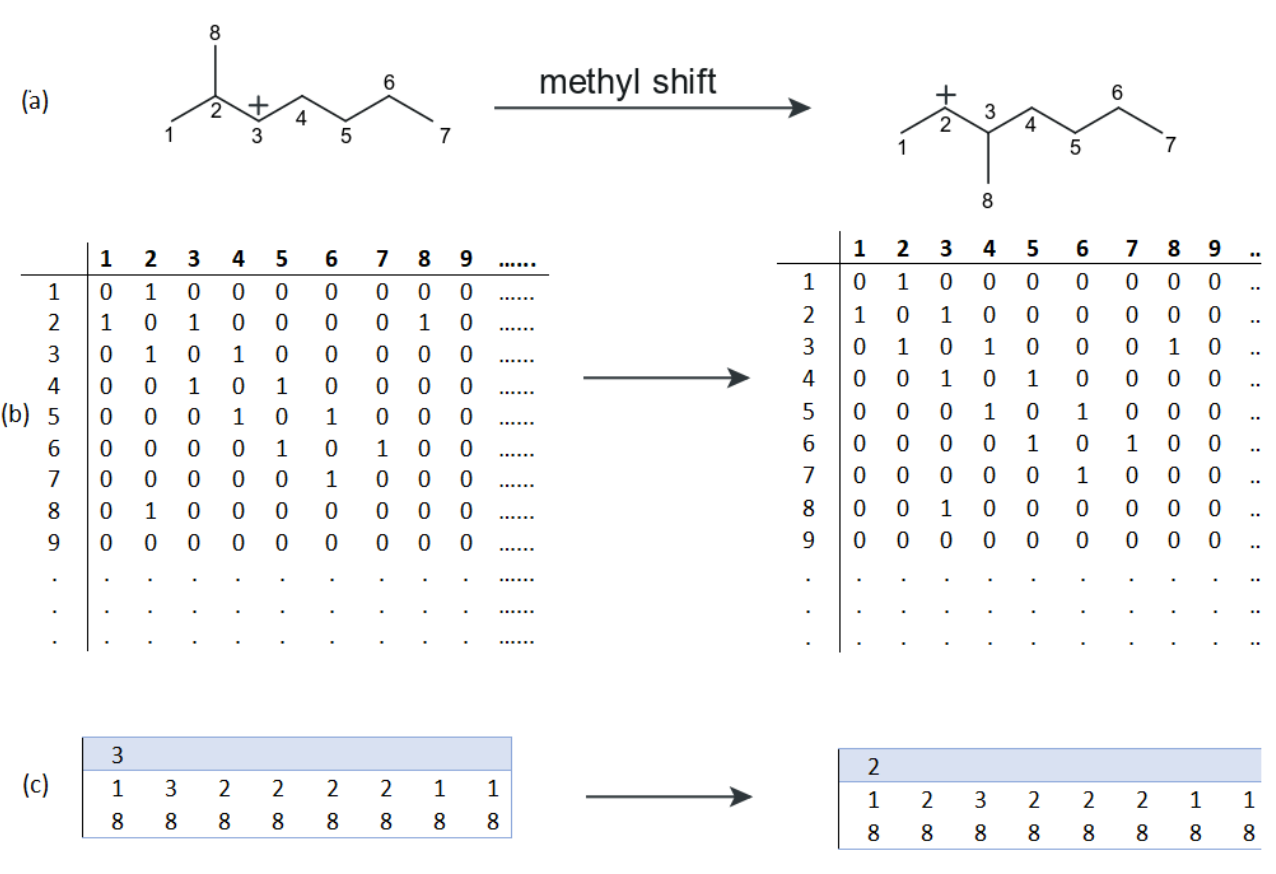
Figure 6. Representation of a methyl shift elementary step of a carbenium ion: ( a ) skeletal form, ( b ) Boolean matrix representation, ( c ) auxiliary vectors for the transformation (7 = unsaturated carbon, 8 = saturated carbon for vector 3), (Adapted from [23]).